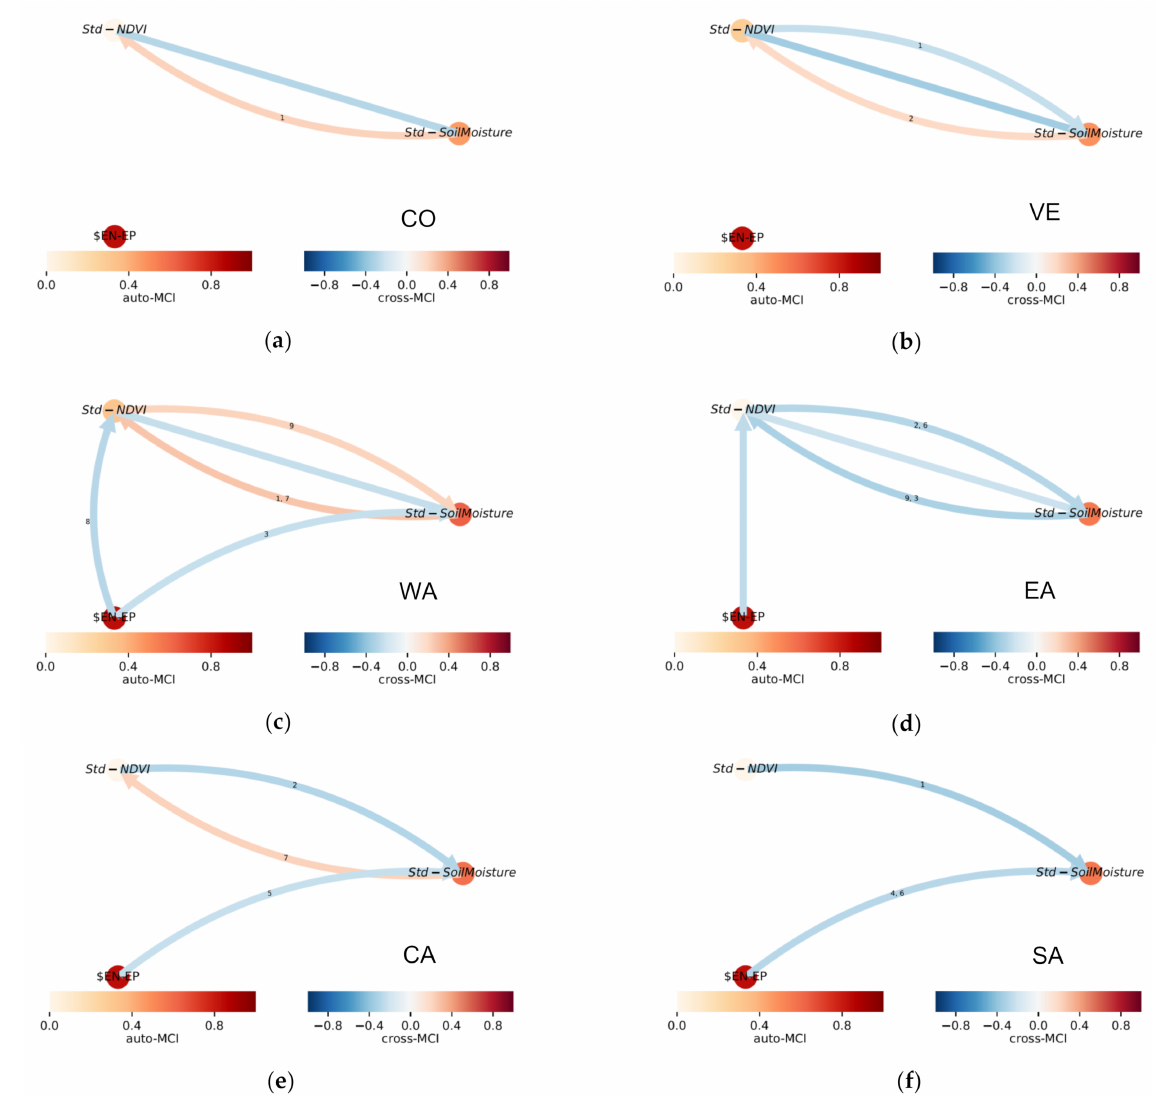
Figure 13. Nonlinear causality analysis based on ParrCorr between the standardized monthly series of NDVI and SMOS, and the Eastern Pacific (EP) index. Node colors denote the nonlinear auto-dependency of each variable, whereas the colors of the lines denote the cross-MCI between both variables and the horizontal lines denotes the simultaneous nonlinear co-dependency. ( a ) CO: Colombia, ( b ) VE: Venezuela, ( c ) WA: West Amazonia, ( d ) EA: East Amazonia, ( e ) CA: Center Amazonia, and ( f ) SA: South